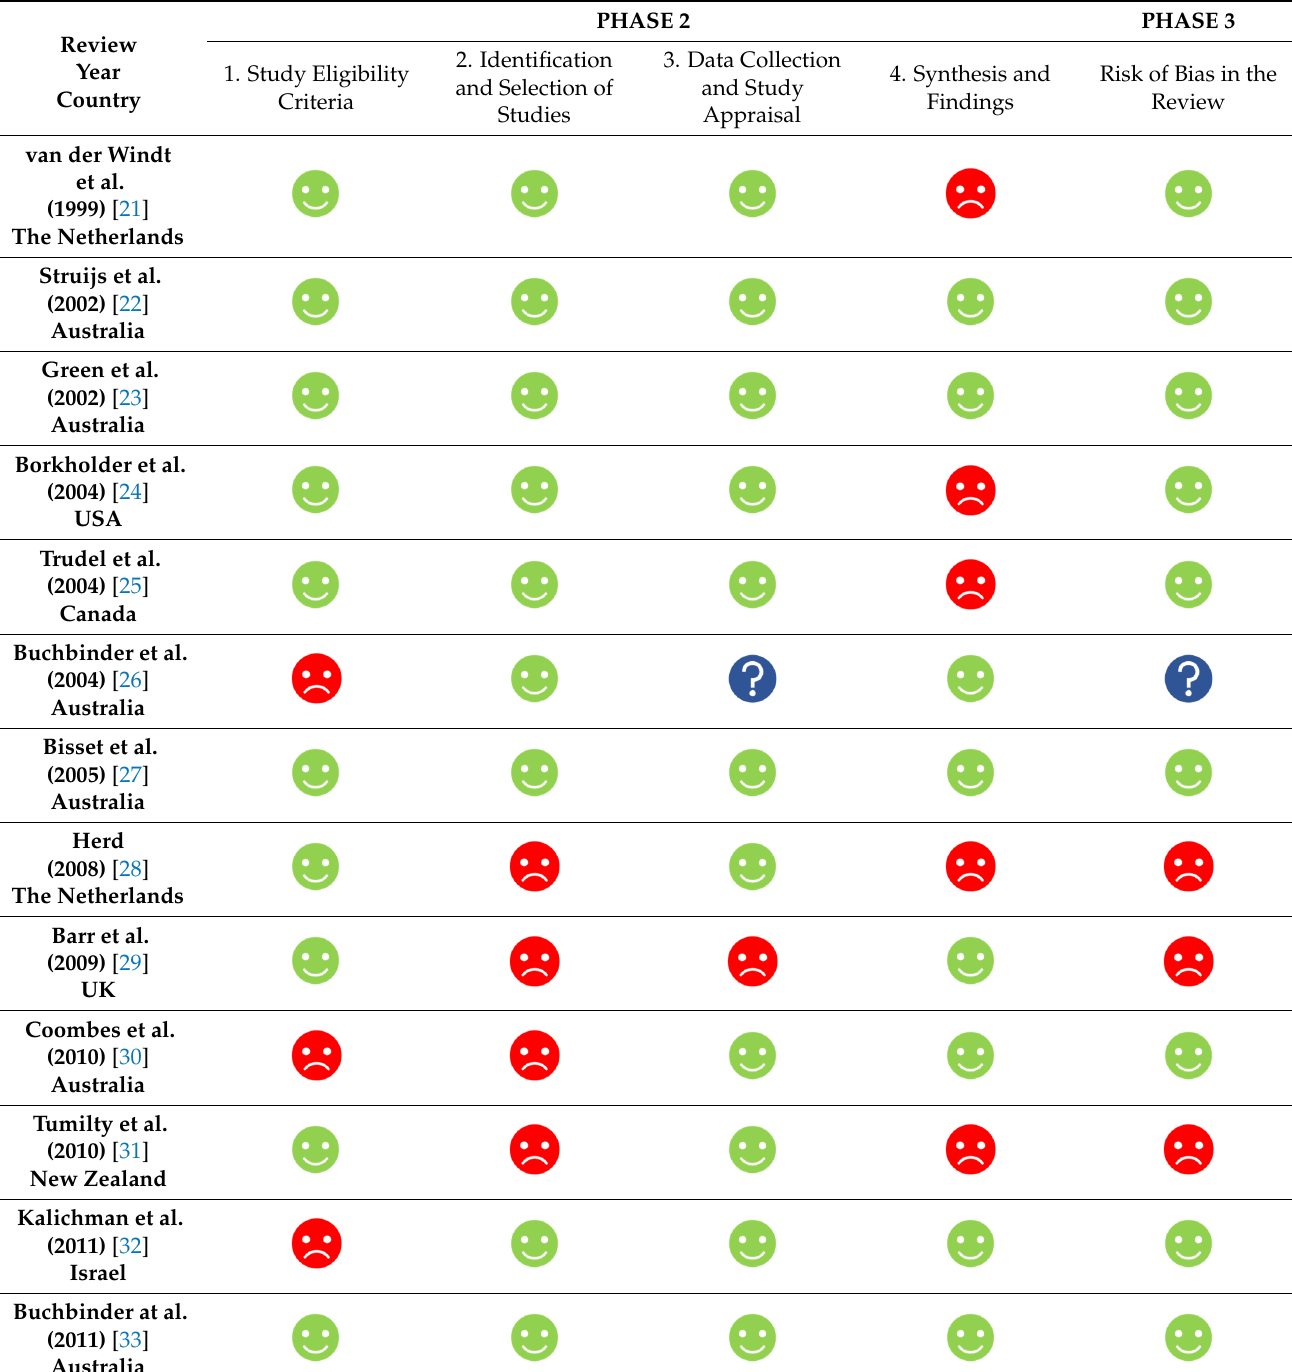
Table 3. RoBis, risk of bias for systematic reviews [18].